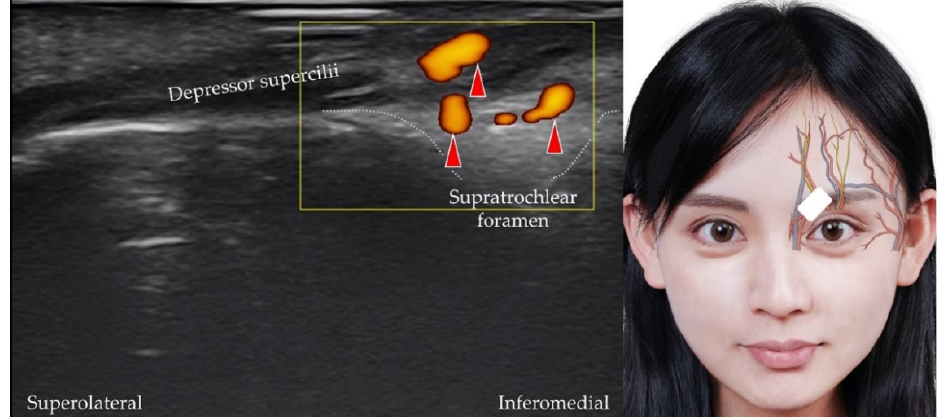
Figure 4. Power Doppler ultrasound imaging of the supratrochlear artery ( red arrowheads ) and its branches. White square , footprint of the ultrasound transducer. White dashed line , border of the supratrochlear foramen.